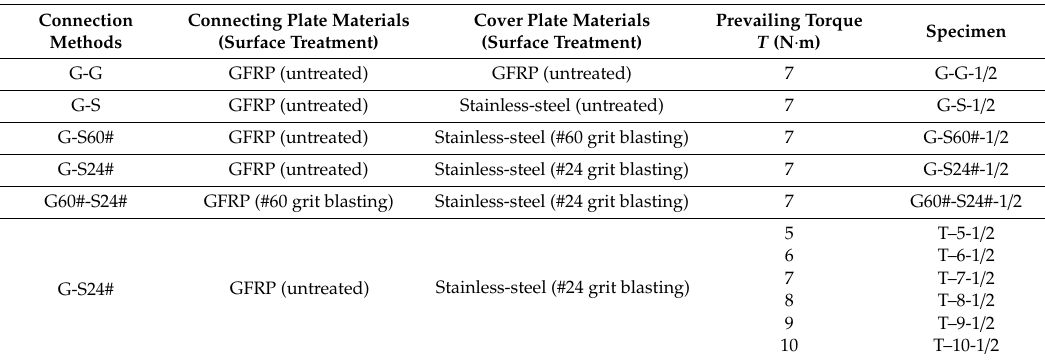
Table 5. Specimens in the shear